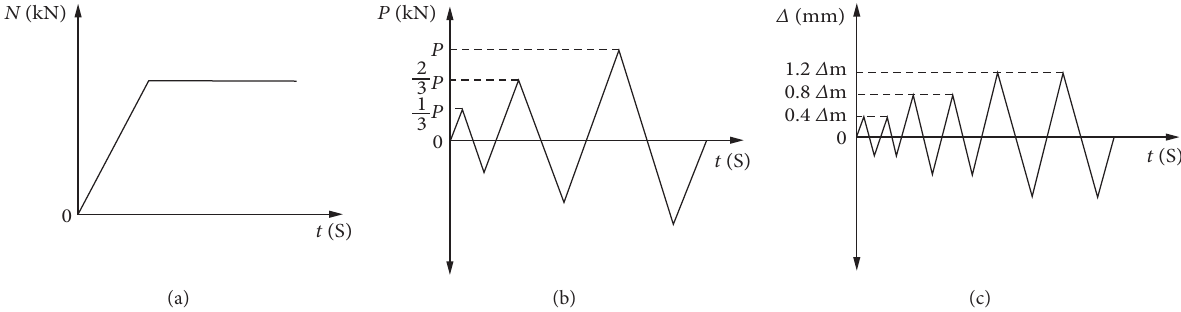
Figure 6: Loading procedure. (a) Axial force loading. (b) Single-cycle loading of lateral force. (c) Double-cycle loading of lateral